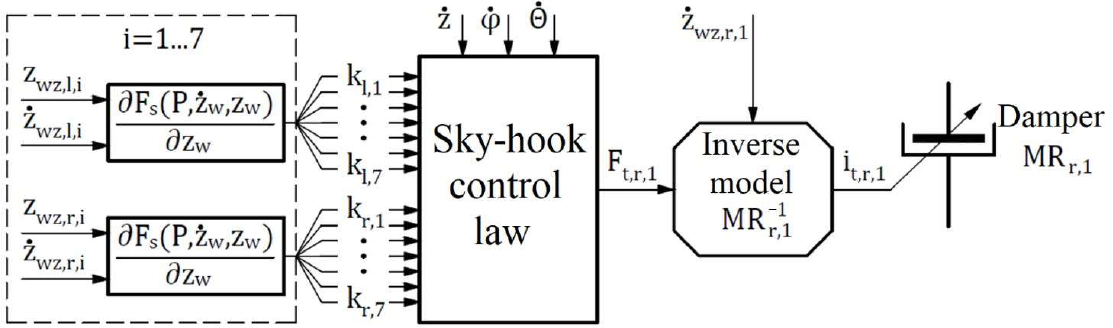
Figure 5. The control law for the magnetorheological damper on the right side and the first axis (MR r,1 ).